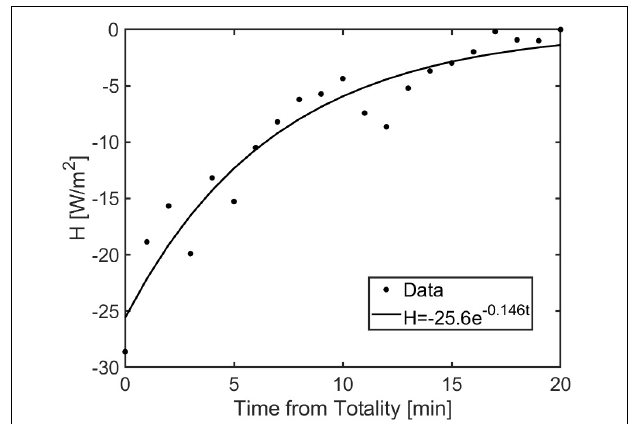
FIGURE 9 | The 1-min STE sensible heat flux response and recovery time scale analysis.